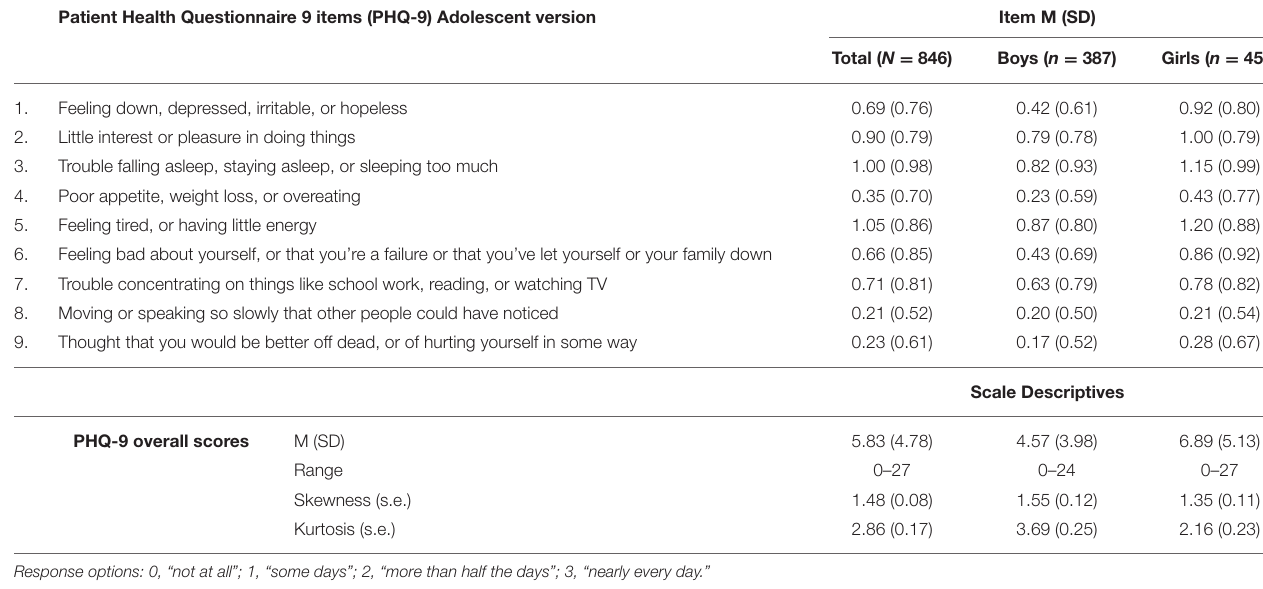
TABLE 2 | The PHQ-9 item and scale descriptives.